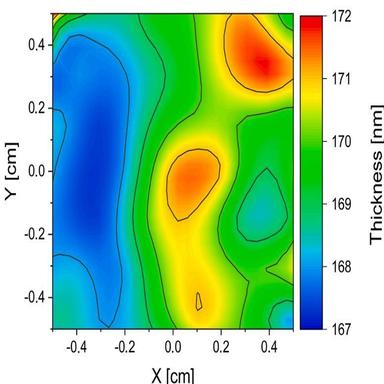
Example of mapped thickness of a TEOS layer deposited on Si wafer. The thickness was deduced according to Cauchy model.